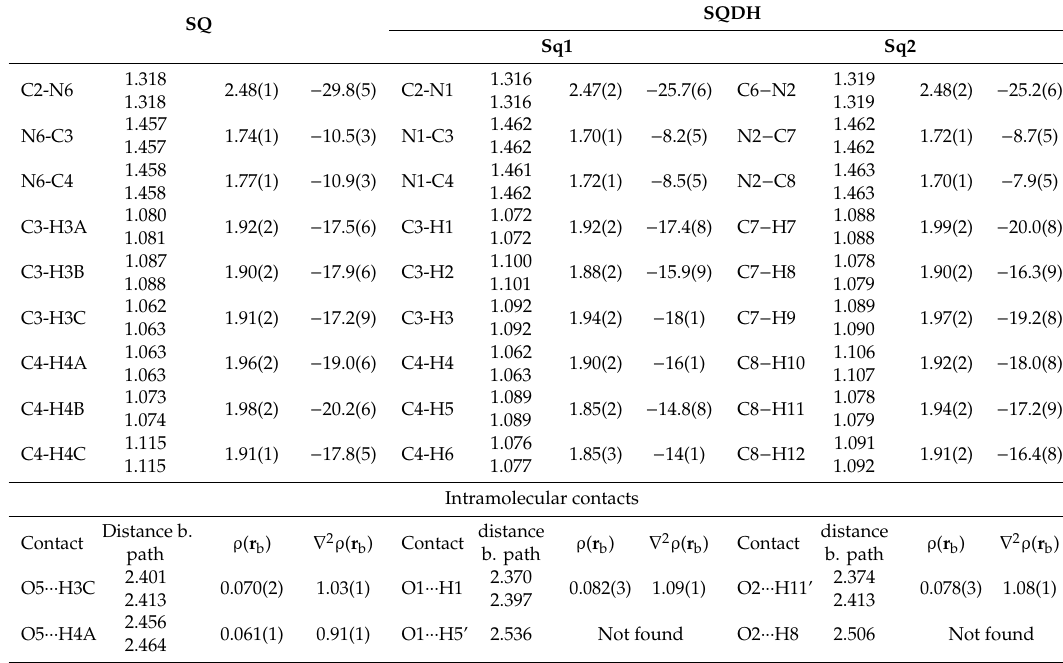
a Estimated standard deviations (esds) for bond lengths are <